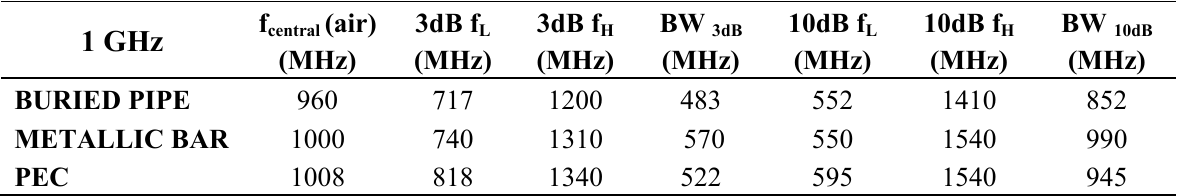
Table 3 . Frequency characteristics of the effective wavelets obtained with the 1 GHz antenna. Measurements were obtained with high stacking (512) to ensure adequate signal stability.